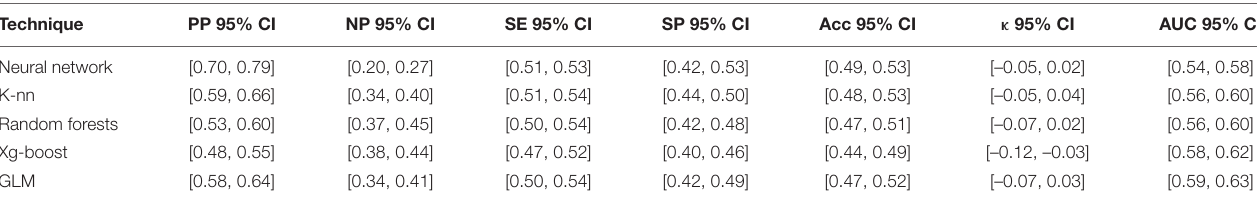
TABLE 7 | Confidence intervals of summary statistics for the predictive ability of the models built with five machine learning techniques in study